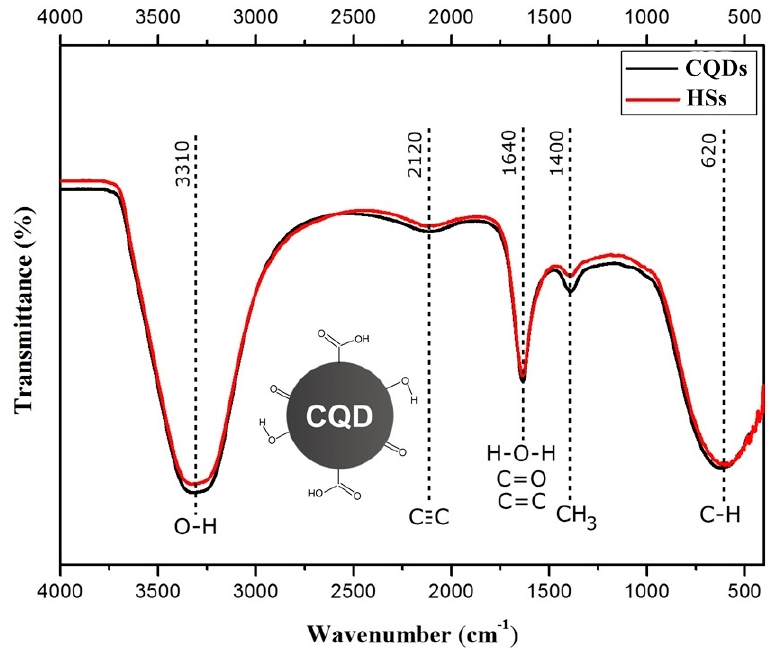
Figure 5. Absorption spectroscopy on the infrared range (FTIR), medium range for solutions containing carbon quantum dots (CQDs) and humic substances (HSs). The inserted figure of a CQD shows the main groups that can be associated with the carbon structure.